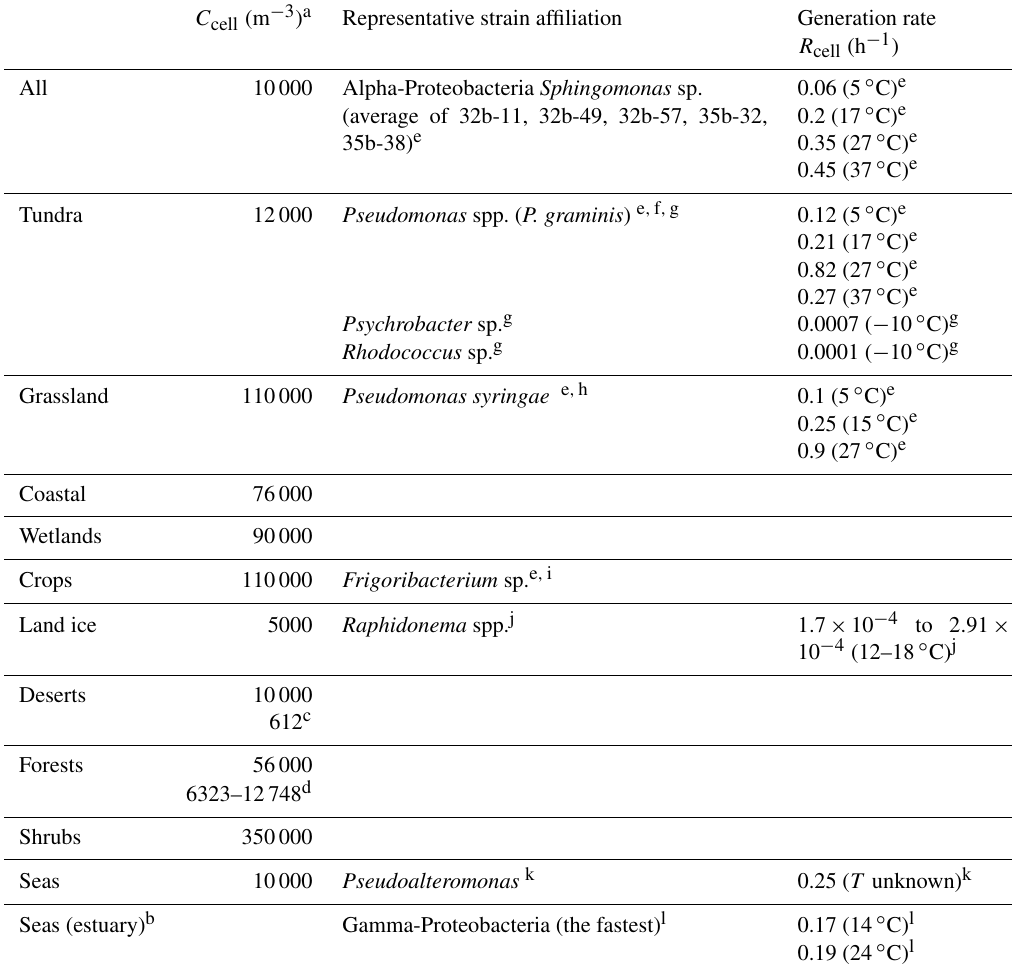
Table 1. Summary of ambient cell concentrations C cell and generation rates R cell for predominant bacteria types in all